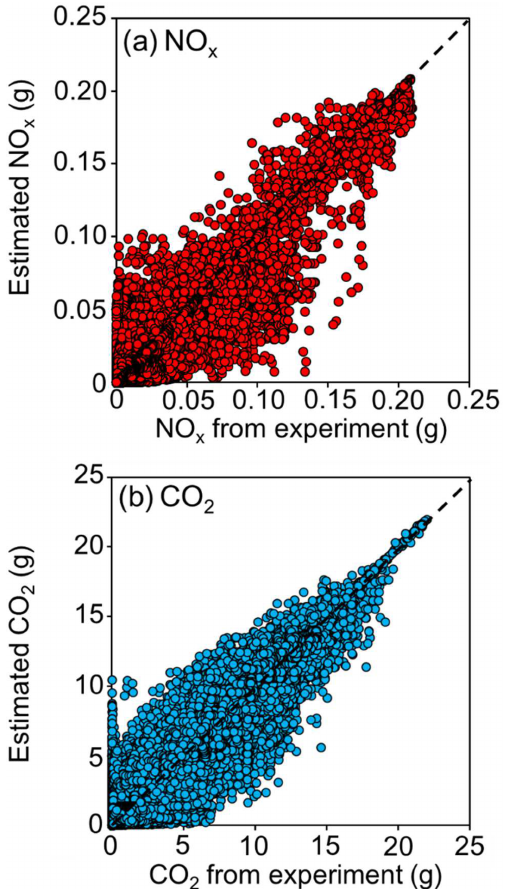
Figure 6. Correlation analysis of amount of (a) NO x and (b) CO 2 emissions measured and estimated using transient